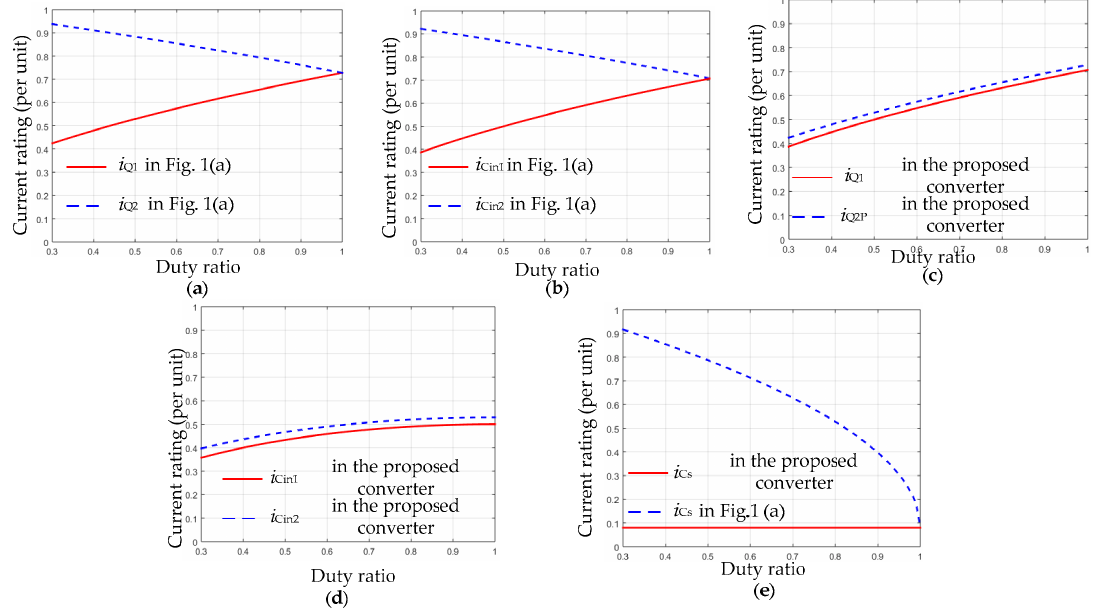
Figure 5. Current of the primary switches: ( a ) i Q1 and i Q2 in Figure 1a; ( b ) i Cin1 and i Cin2 in Figure 1a; ( c ) i Q1 and i Q2P in the proposed converter; ( d ) i Cin1 and i Cin2 in the proposed converter; ( e ) i Cs .